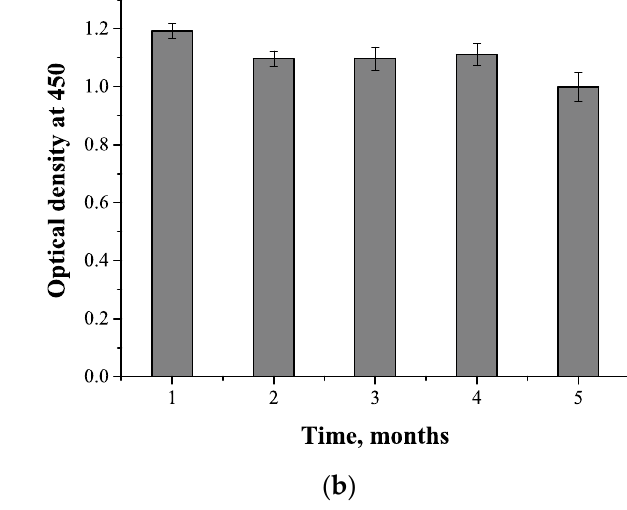
b—11.8 × 10 − 10 M TA-capped AuNPs + 0.5M H 2 O 2 + 0.5 mM TMB; c—11.8 × 10 − 10 M TA-capped AuNPs +